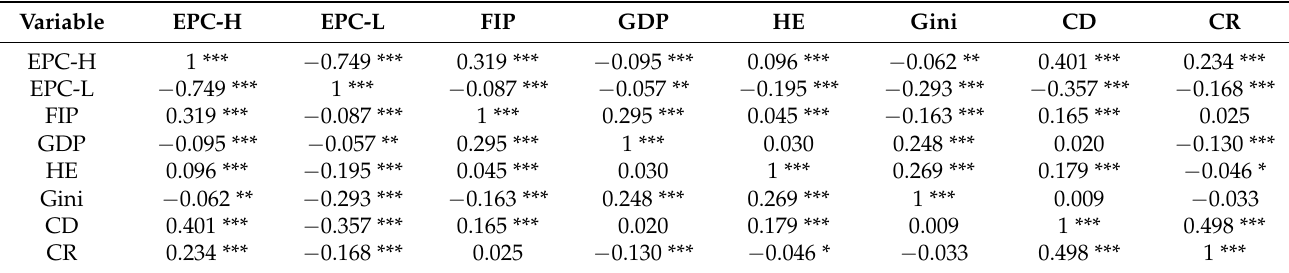
Table 4. Correlation